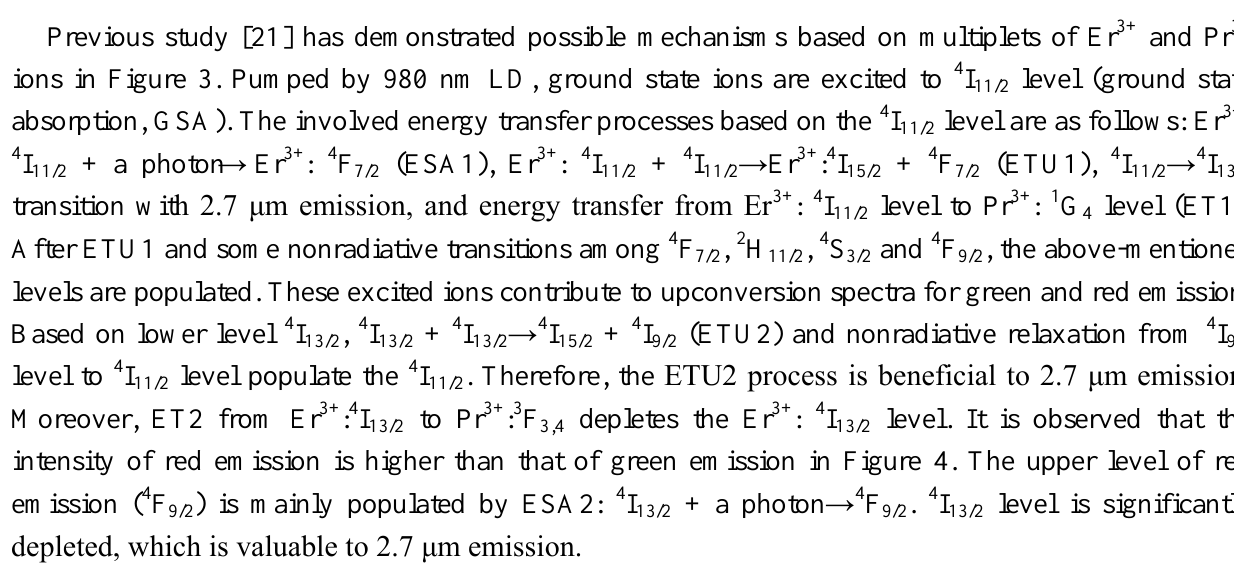
, branching ratio ( β ) and radiative lifetime in Er 3+ and rad